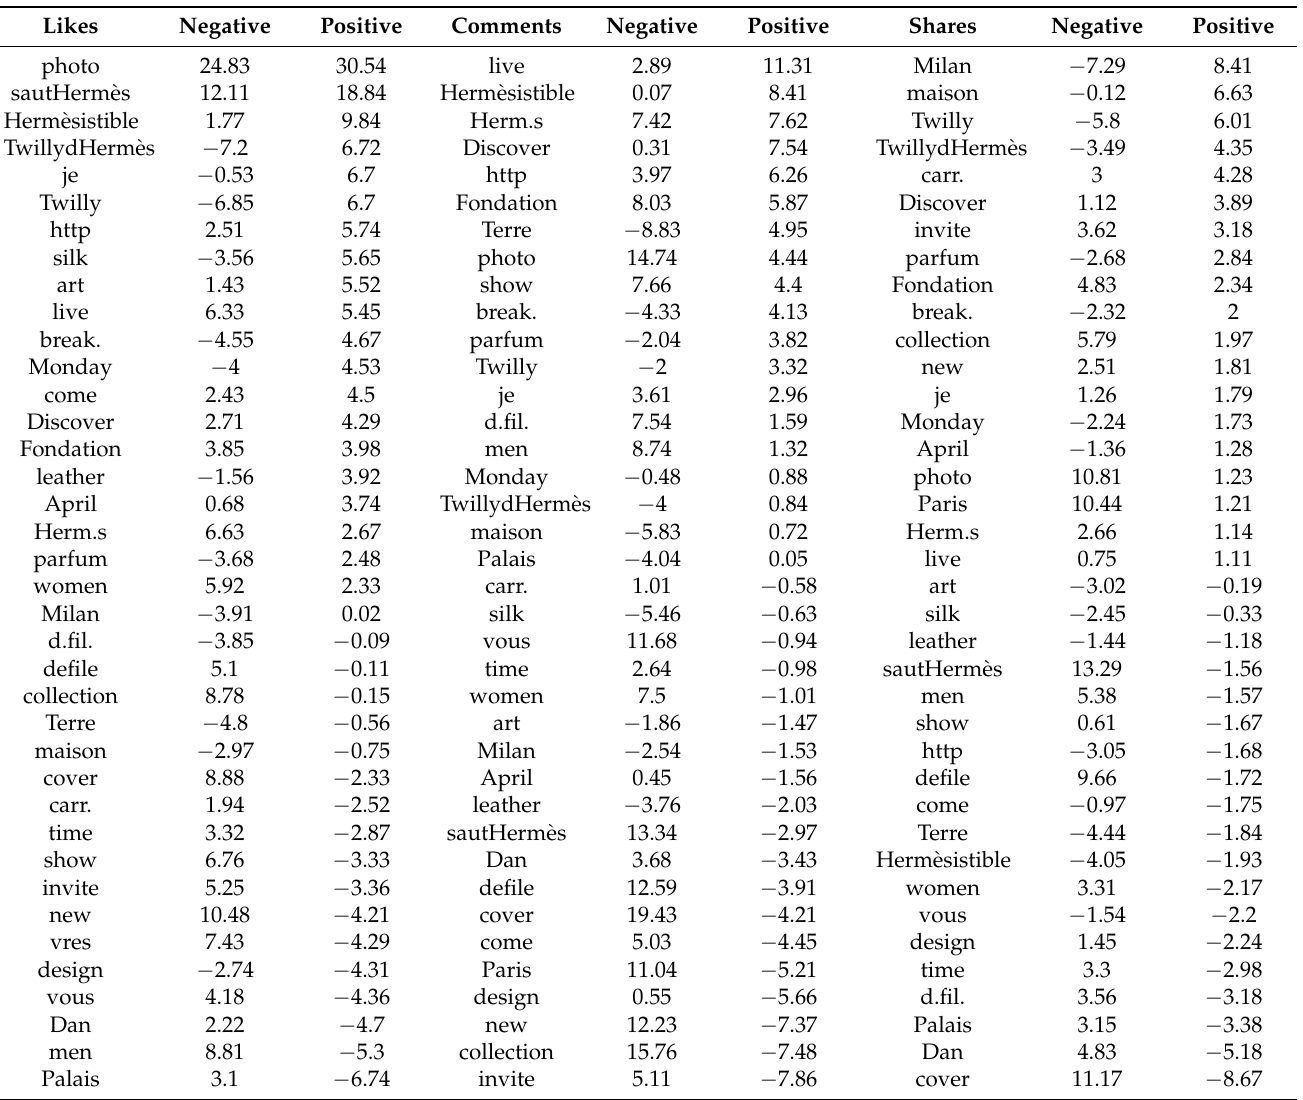
Table A2. Negative and positive cues for Herm è s.